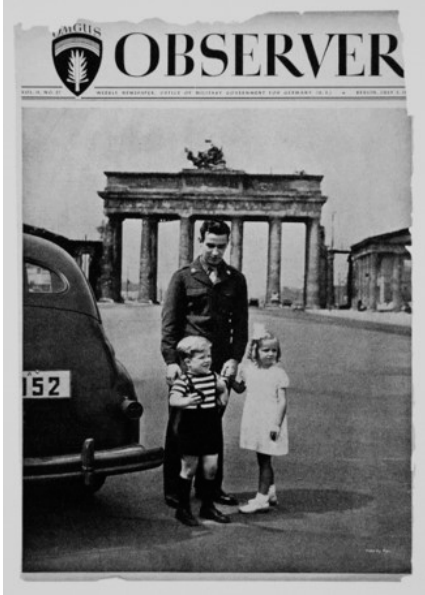
Figure 11. Henry Ries. Brandenburg Tor (Brandenburg Gate) , OMGUS Observer , vol. 11 no. 27, 5 July 1946. Photograph. © Henry Ries. German Historical Museum. Invoice No. 2008/921.60, file PH009719. Arts 2020 , 9 , x FOR PEER REVIEW